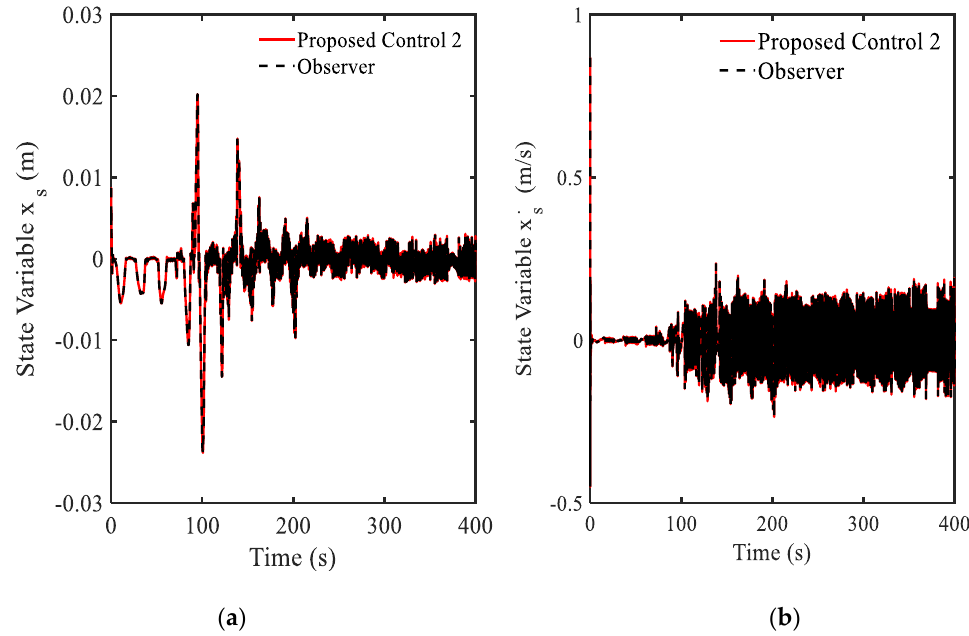
Figure 16. Vibration control results at the driver position under random step wave road excitation: ( a ) displacement, ( b ) velocity.